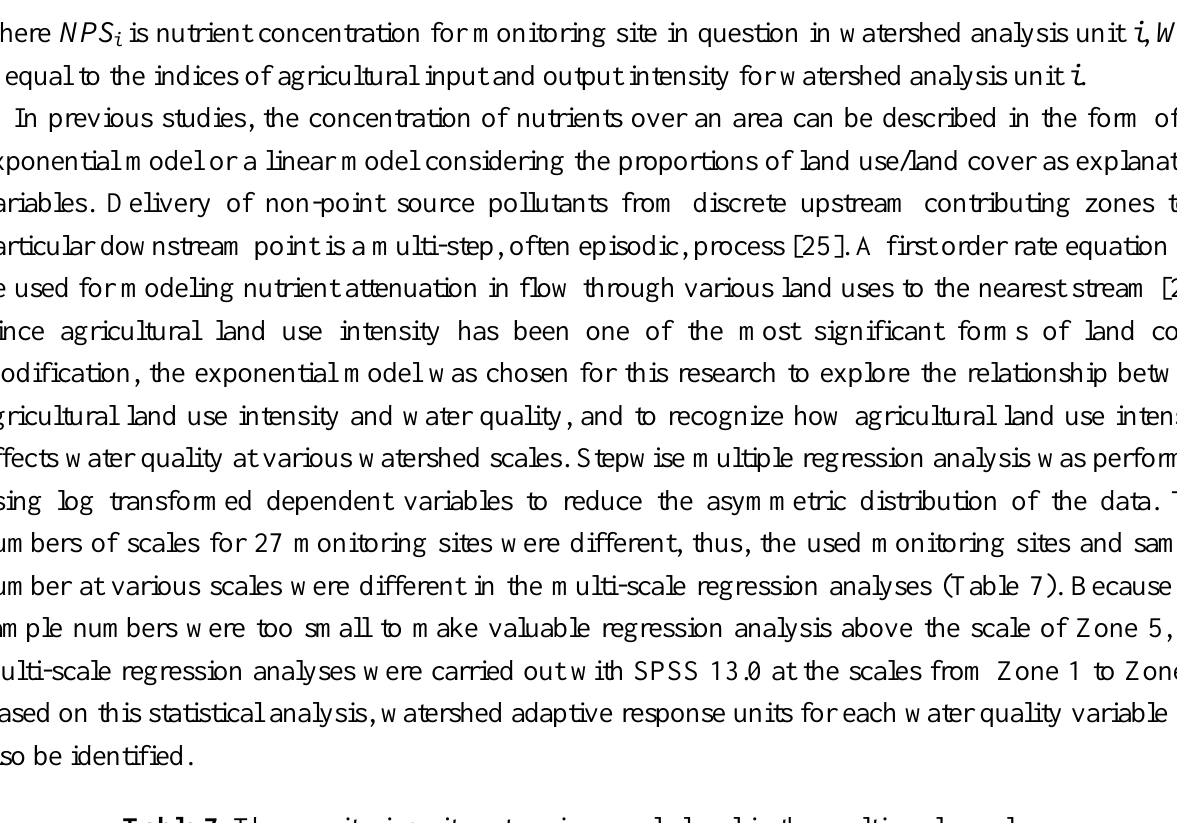
Table 7. The monitoring sites at various scale level in the multi-scale